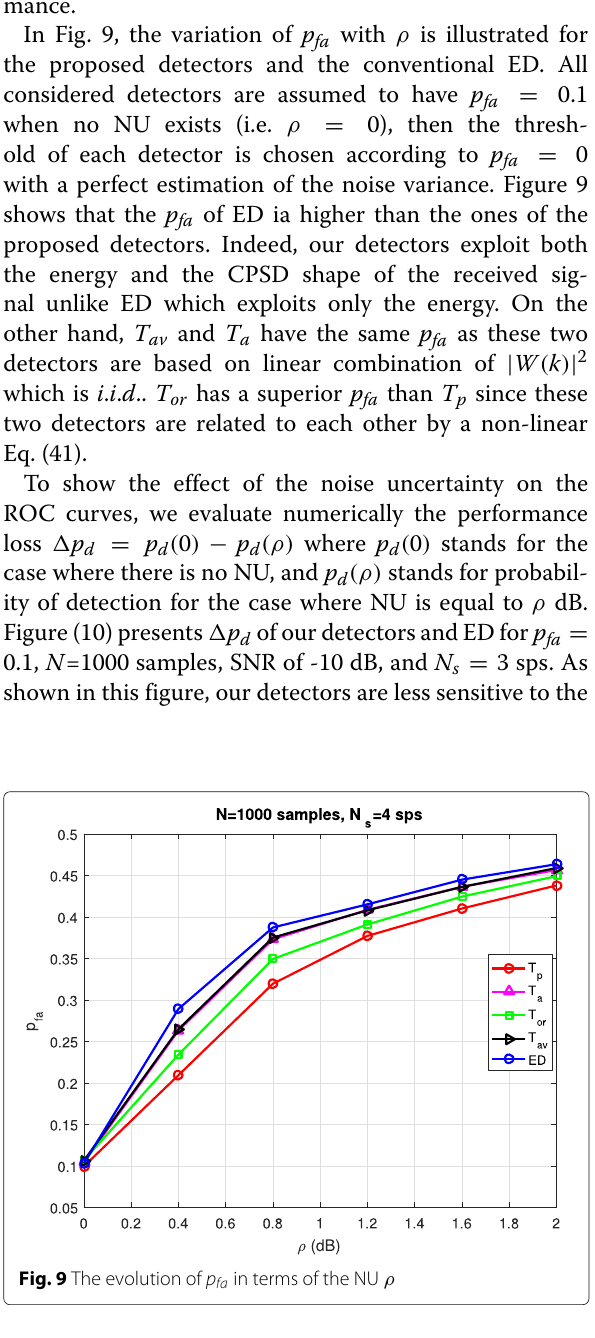
Fig. 9 The evolution of p fa in terms of the NU